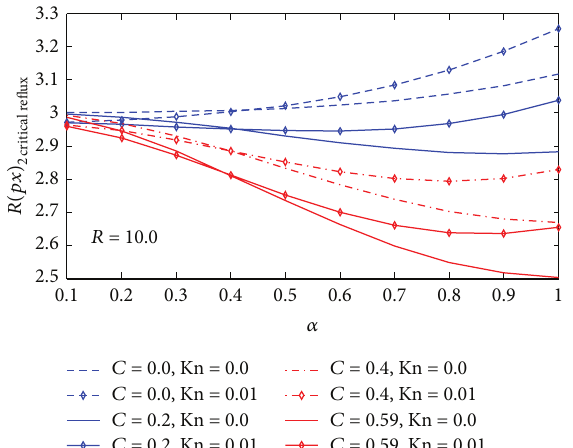
Figure 2: Effect of the Knudsen number Kn, particle concentration 𝐶 , and wave number 𝛼 on the critical reflux pressure gradient at 𝑅 = 10 .